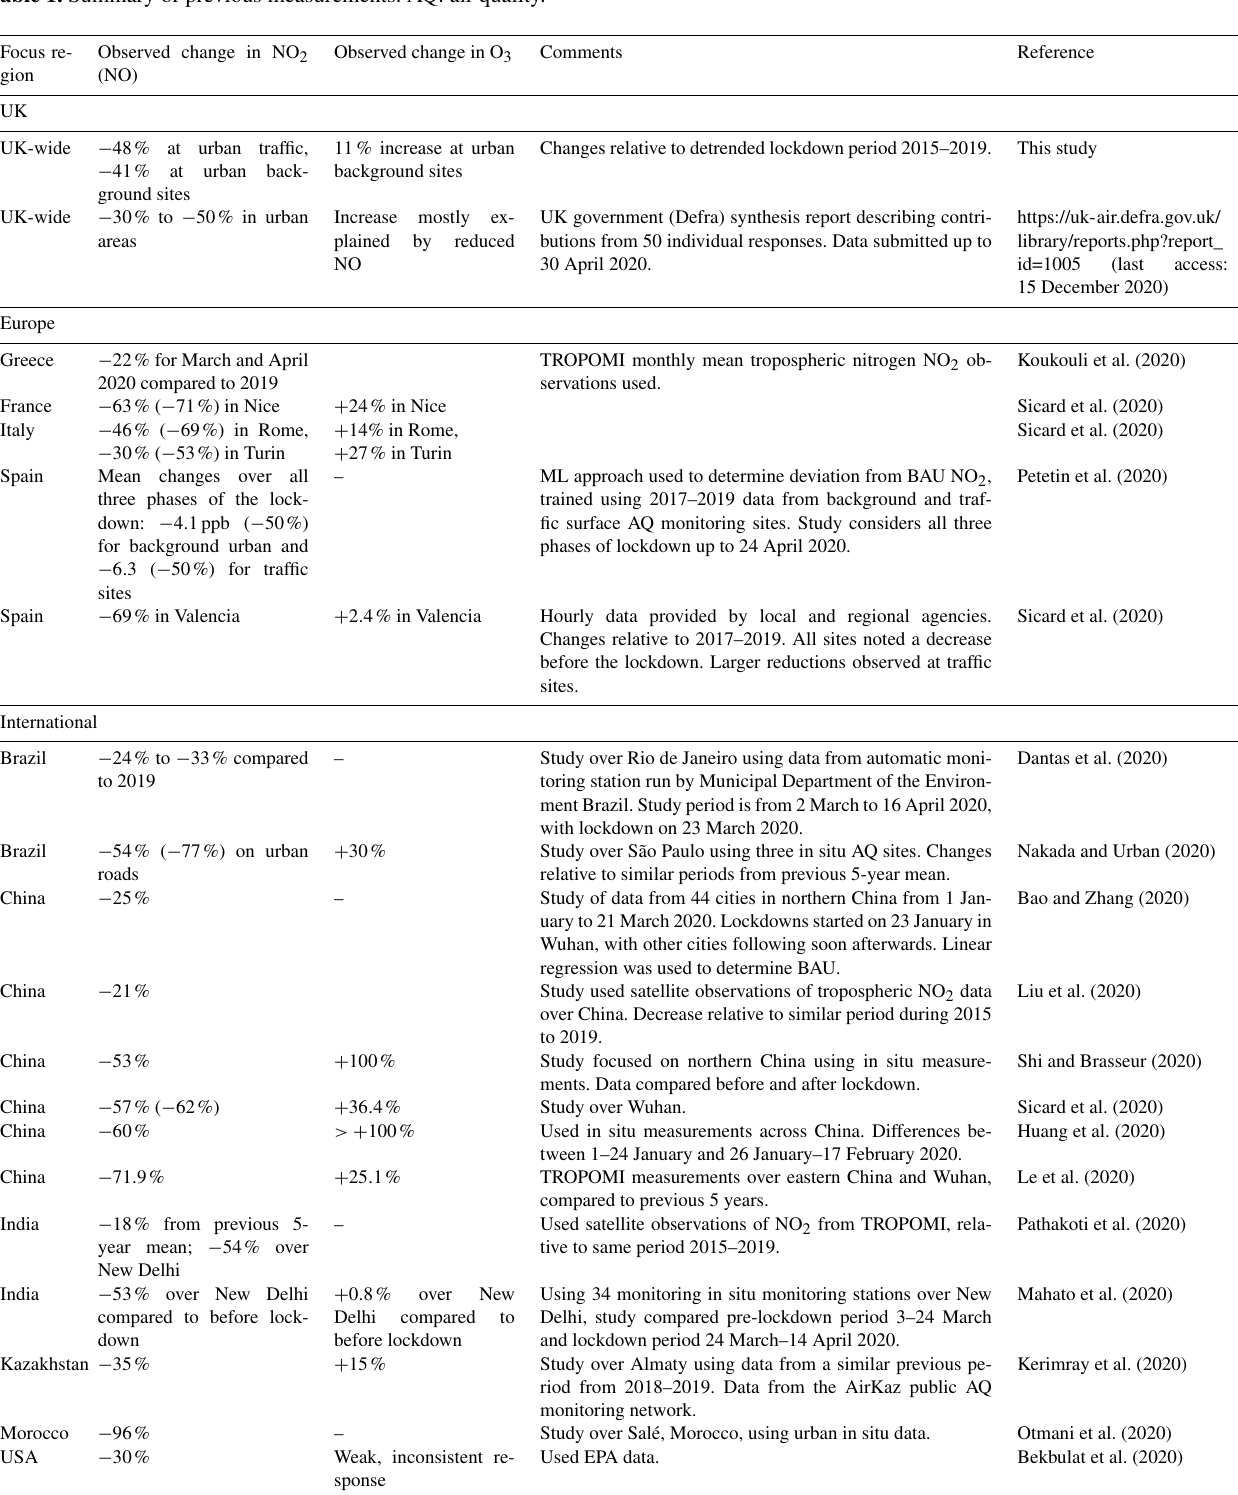
Observed change in O 3 Comments Reference 11% increase at urban Changes relative to detrended lockdown period 2015–2019. This study background sites